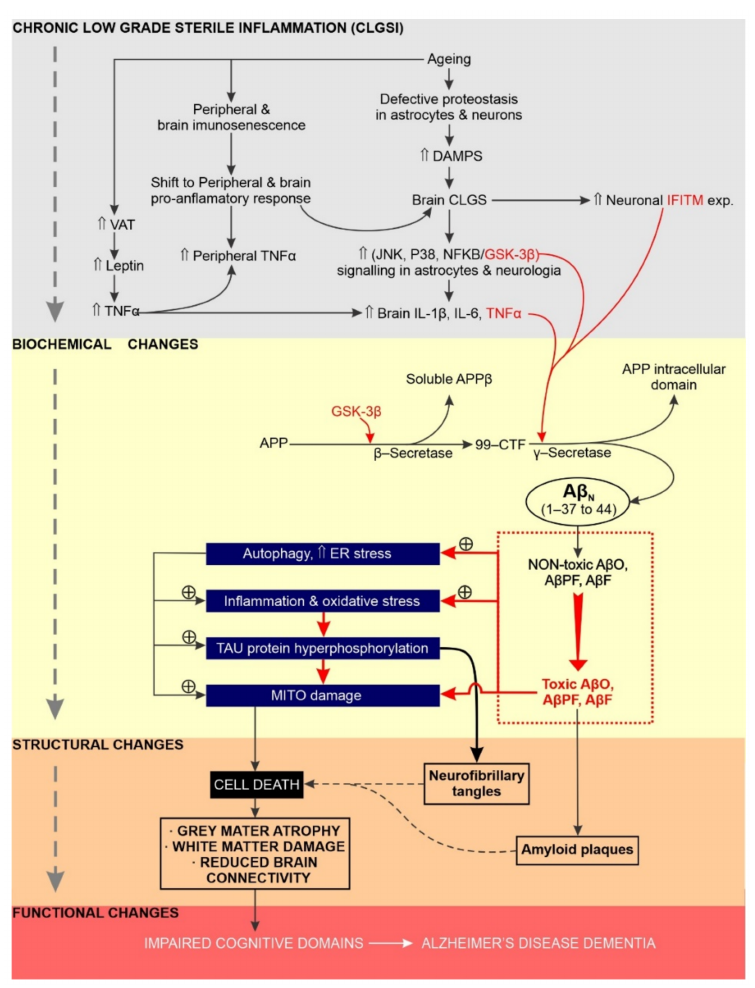
Figure 1. Chronic low grade sterile inflammation promotes AD-related changes in APP